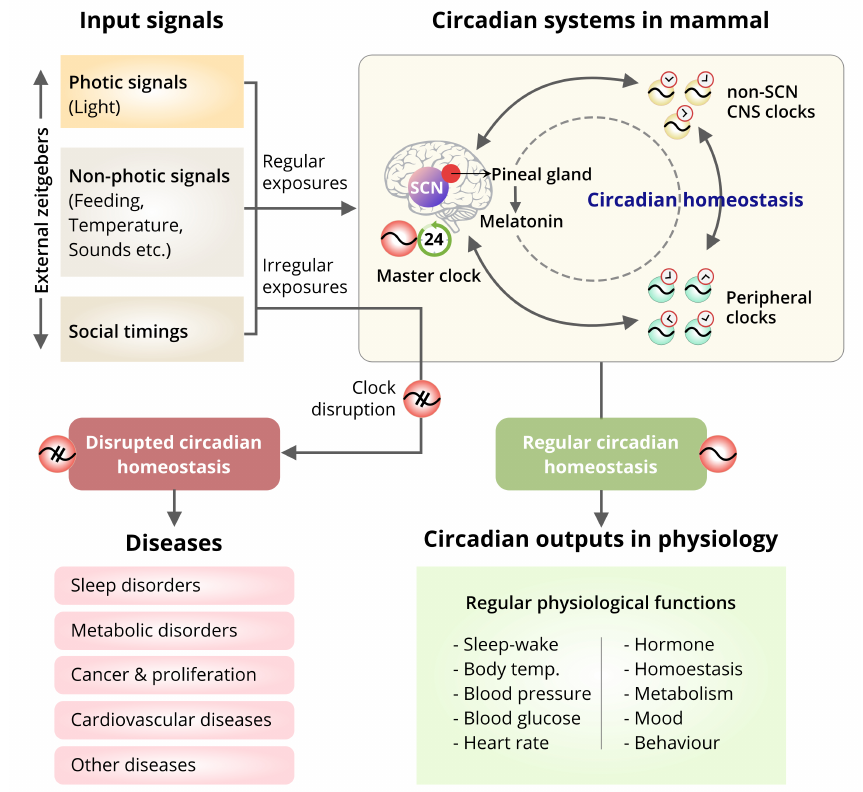
Figure 4. The association of the input signals, circadian homeostasis, and diseases. Intertwining interactions between the circadian clock and diseases are complex, and essentially depend not only on physiological factors alone, but also the influence of the different zeitgebers like, lights, sounds, temperature, feeding behaviors, lifestyles, and social timing received by the individual. Every individual clock needs to be synchronized within the tissue to sustain the stable phase-relationship to render the clock-mediated rhythmic information. The cellular clocks perceive the input signals by responding to the stimuli (input signals), integrate the phases to sense the temporal information and transmit the rhythmic information to other cells (circadian outputs) to adjust the indigenous clock timing with the external cues. This homeostatic mechanism drives the temporal regulations of different physiological functions. Disruption of such homeostasis leads to abnormal physiological activities and develops different